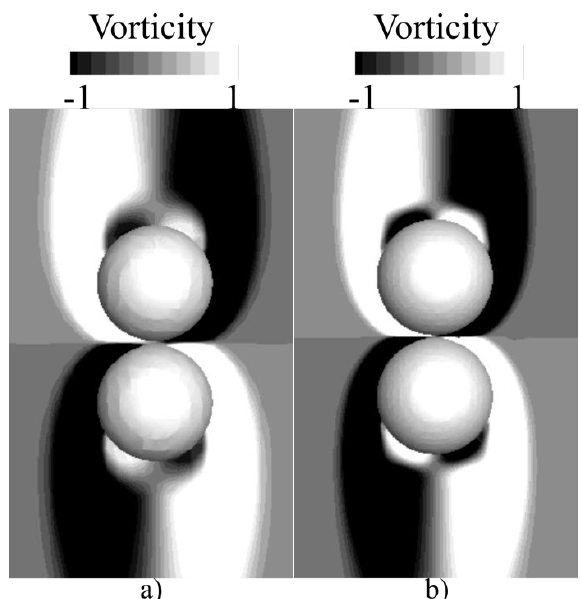
Figure 15. Vorticity distributions during a particle–particle collision: ( a ) coarse mesh, ( b ) fine mesh.